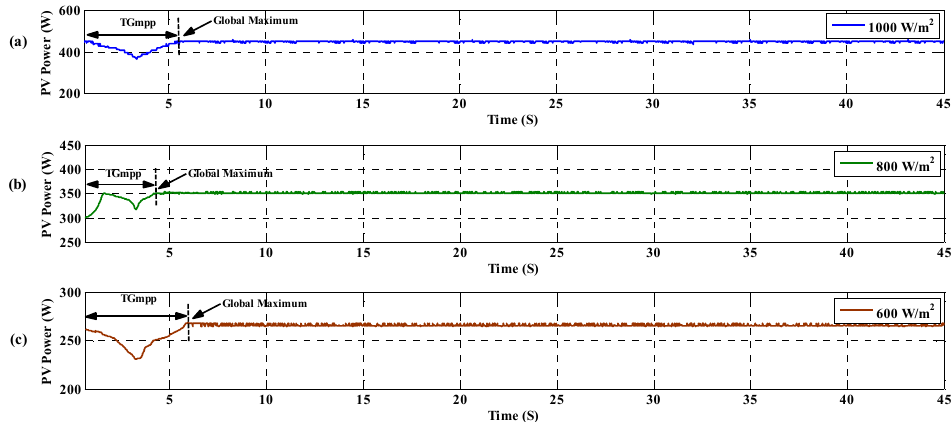
Figure 23. PV output power for the scenario in Figure 22 for irradiations of ( a ) 1000 W/m 2 ; ( b ) 800 W/m 2 and ( c ) 600 W/m 2 .